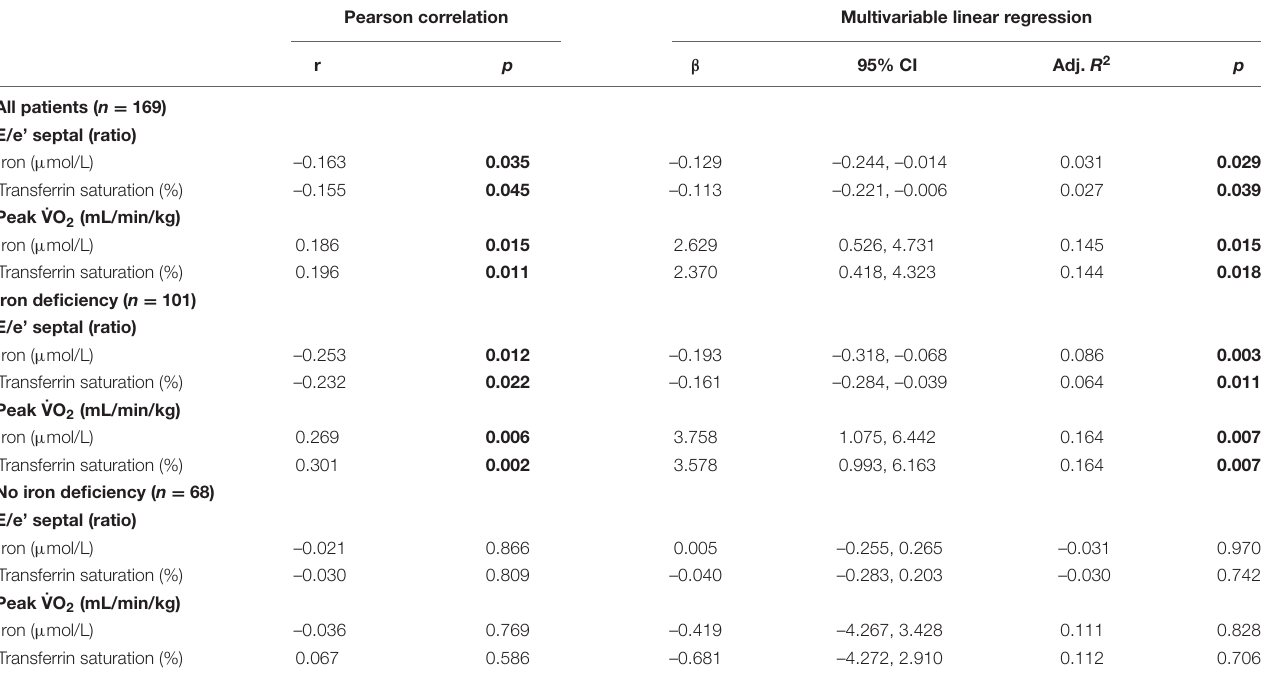
TABLE 2 | Associations of baseline iron status with cardiac function and aerobic exercise capacity. Pearson correlation Multivariable linear